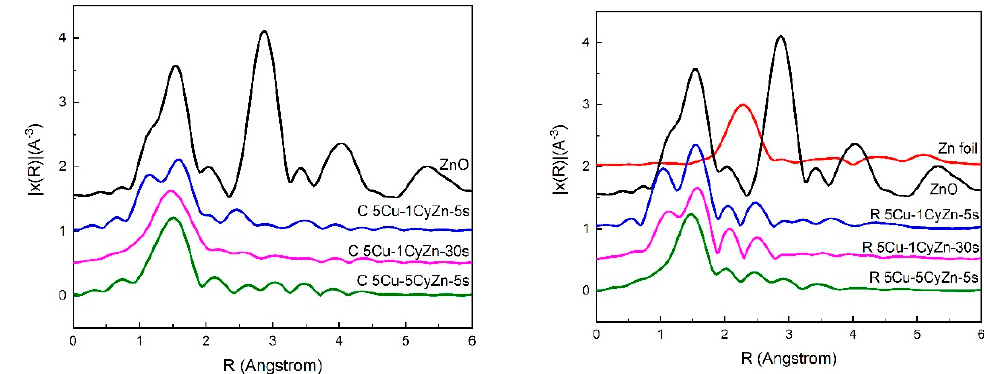
Figure 11. Experimental EXAFS spectra registered Zn K-edge of calcined ( left ) and reduced ( right ) SEA-5Cu and ZnO over-coated Cu/SiO 2 catalysts.